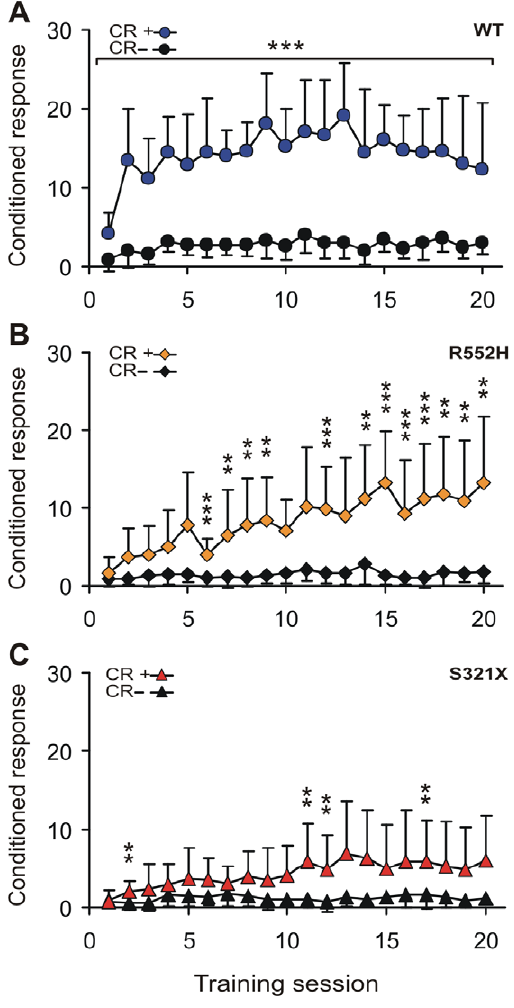
Figure 1. Learning curves of wildtype (a), heterozygous R552H mutant (b), and heterozygous S321X mutant (c) mice. For all 20 training days (one training session per day) the mean numbers of jumps across the hurdle averaged from the performances of the 11 animals per experimental group are shown. The animals could show hits (CR + ) in the presence of 12 kHz tones or false alarms (CR 2 ) in the presence of 7 kHz tones. Since each training session consisted of 60 trials with 30 randomized presentations of both CS + and CS 2 a maximum of 30 hits and 30 false alarms could be reached if the animals responded to each tone with a jump, irrespective of the tone frequency. The larger the distance is between the CR + and CR 2 curves the better is the learning performance. Standard deviations of the means are shown only for one side to improve readability of the data. Statistically significant differences between the CR + and CR 2 rates calculated for each training session are indicated as ** p , 0.01; *** p , 0.001.